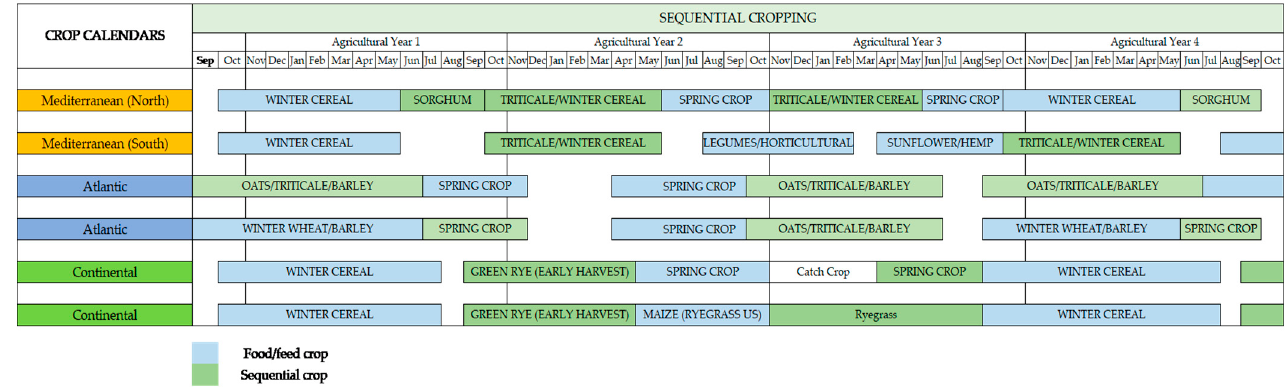
Figure 2. Classic calendar crop (Agri4Cast data). The periods in which each crop is cultivated is differentiated with the three colors.